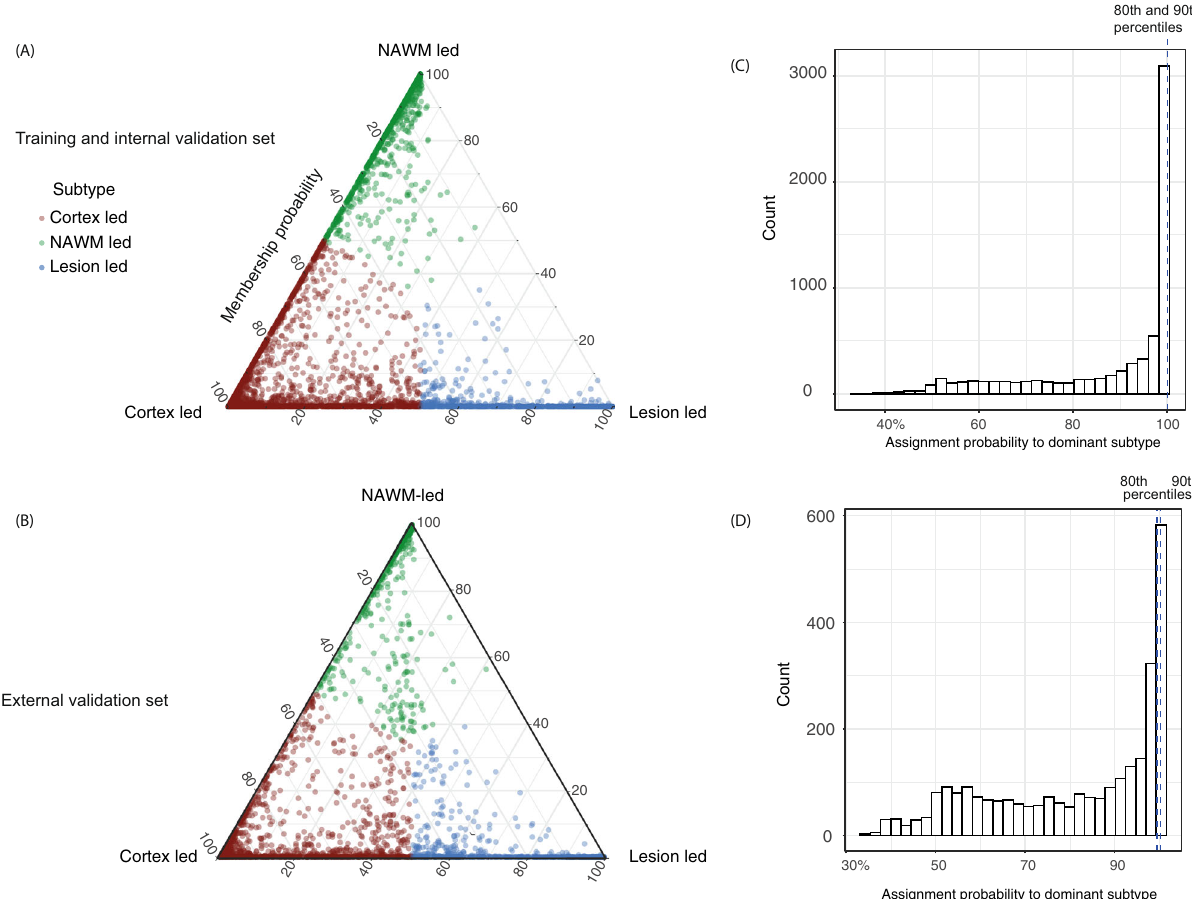
Fig. 2 Subtype membership in the training, and validation datasets. a MRI-based subtypes in the training and internal validation dataset and b the validation dataset. Assignability of the disease subtype, or membership probability, is shown as the distance from each vertex of the triangle. Each of vertices represent the point at which membership of a given subtype is at its maximum (100%). We assigned each subject to one subtype (shown in red, green and blue) based on their maximum probability. c , d The 80th and 90th percentiles for the probability of assignment to the dominant subtype was 99.98% and 99.99% (indistinguishable in the fi gure) in the training dataset. In the validation dataset these percentiles were 99.45% and 99.97% respectively.